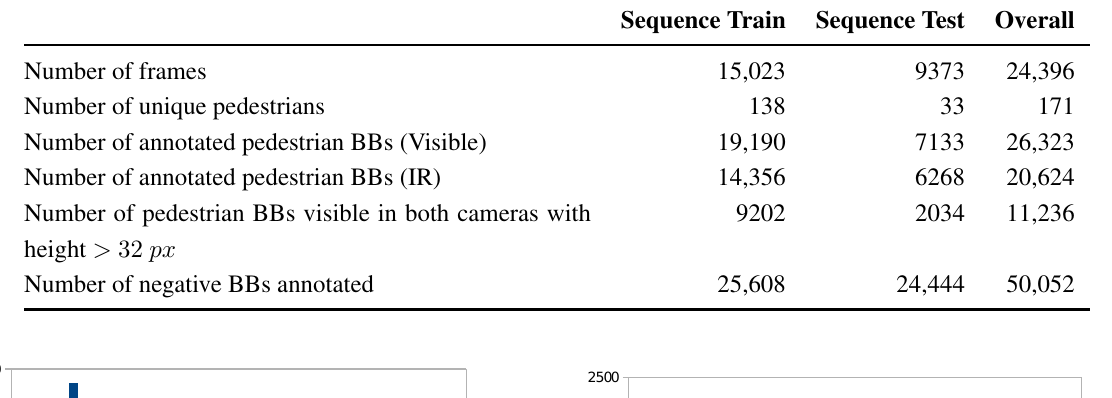
Table 3. RIFIR dataset statistics.